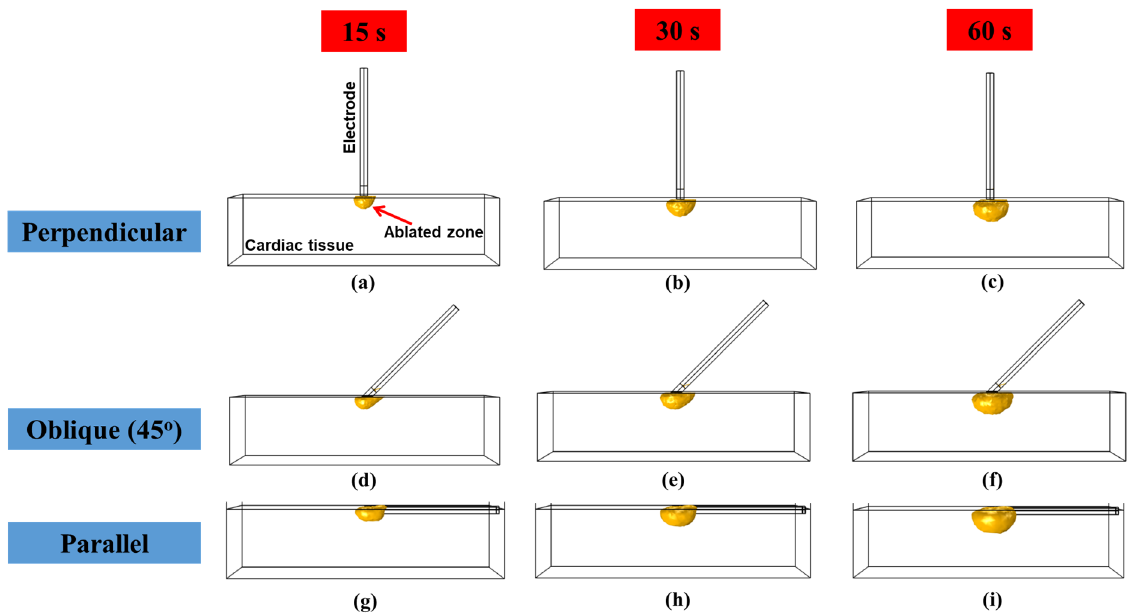
Figure 7. Propagation of ablation zone during 60 s of cardiac ablative procedure for: ( a – c ) perpendicular (90°), ( d – f ) oblique (45°), and ( g – i ) parallel (0°) configuration of electrode.